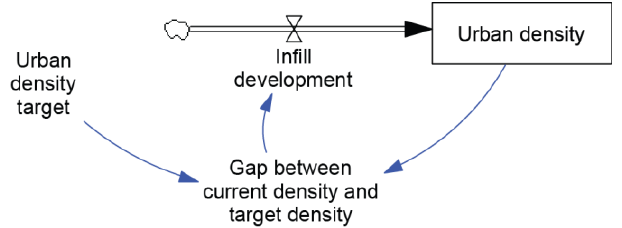
Figure 7. The Compact Mechanism.